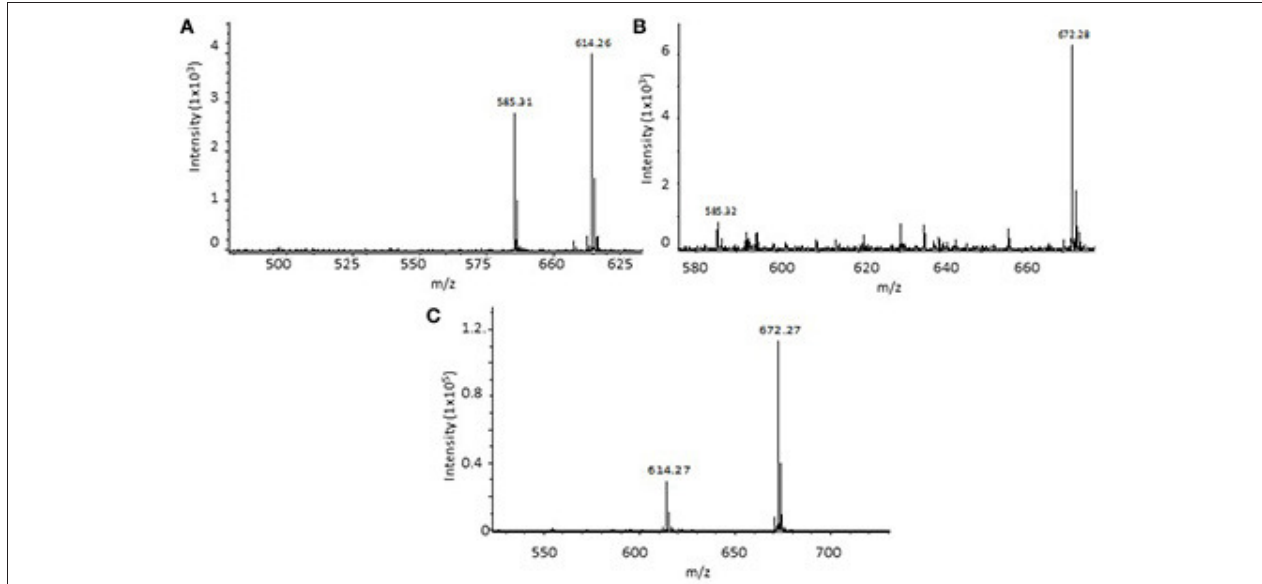
FIGURE 5 | Mass spectra of particle bioremineralization sample station 1, 30m at the end of the incubation, eluting at retention time (RT) 8.0 and 8.3min, respectively. (A) mass resembling ferrioxamine B and (B) ferrioxamine G. Mass spectra of [M + H + Fe-3H] + ferrioxamine B (m/z 614) and G (m/z 672) from a mixed ferrioxamine standard (RT 8.2min) (C)